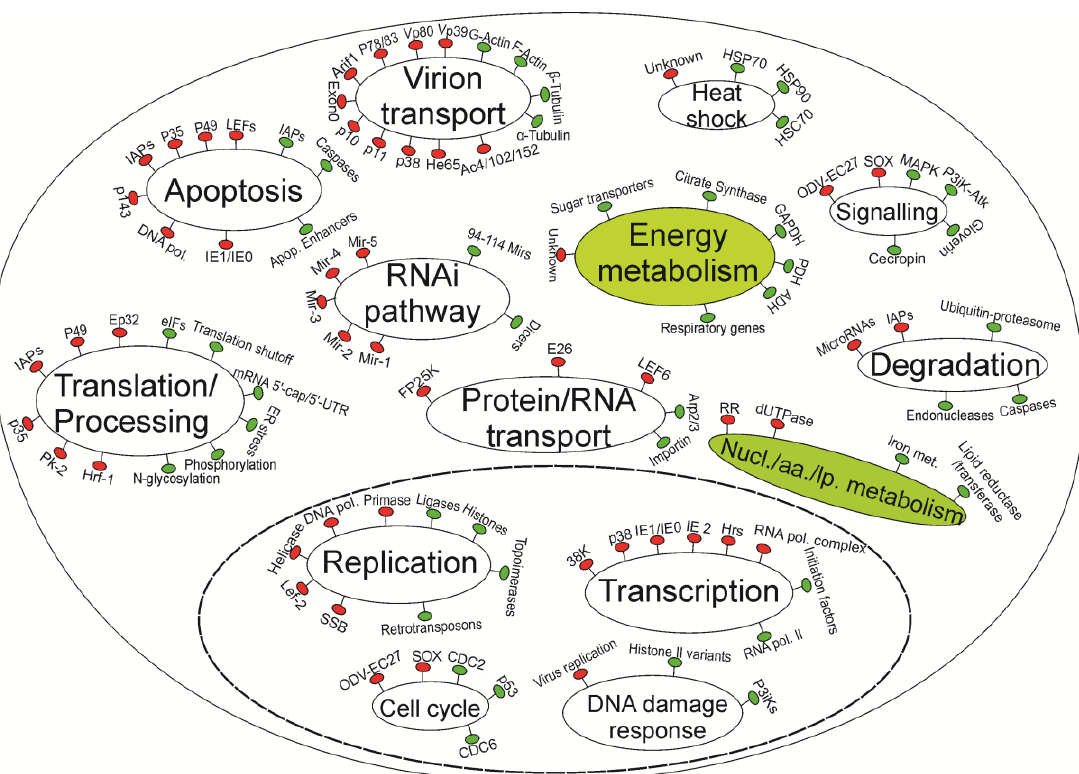
Figure 1. A simplified model of current understanding of host-baculovirus interactions. Virus genes/processes are in red, and insect genes/processes are in green. Major pathways are indicated by ellipses. The left half of the diagram represents pathways that are relatively well understood. The right half shows pathways that deserve more research, especially those indicated by filled ellipses. The ellipse with dashed boundary represents the nuclei. The nucl./aa./lp. abbreviation stands for nucleotide/amino acid/lipid metabolism